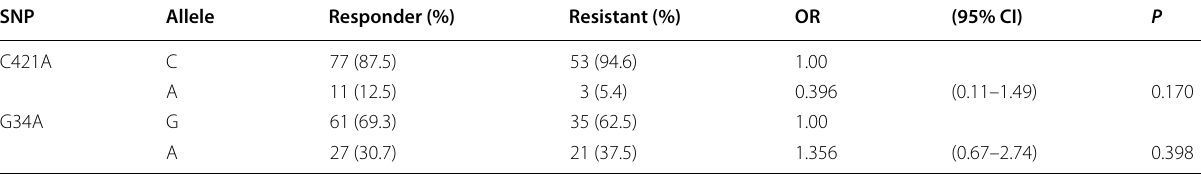
Table 3 C421 and G34A allele frequencies in the responder and resistant groups